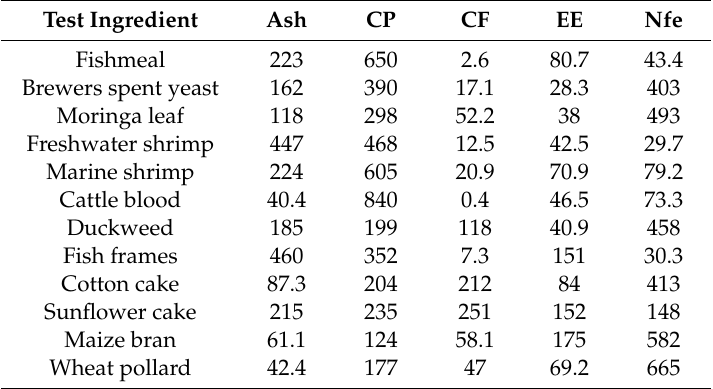
(Table 1). The proximate chemical composition of the other dietary ingredients (i.e., cotton seed cake, sunflower seed cake, maize bran and wheat pollard) are shown in Table 1. Table 1. Chemical composition (g / kg DM) of the reference diet and test diet